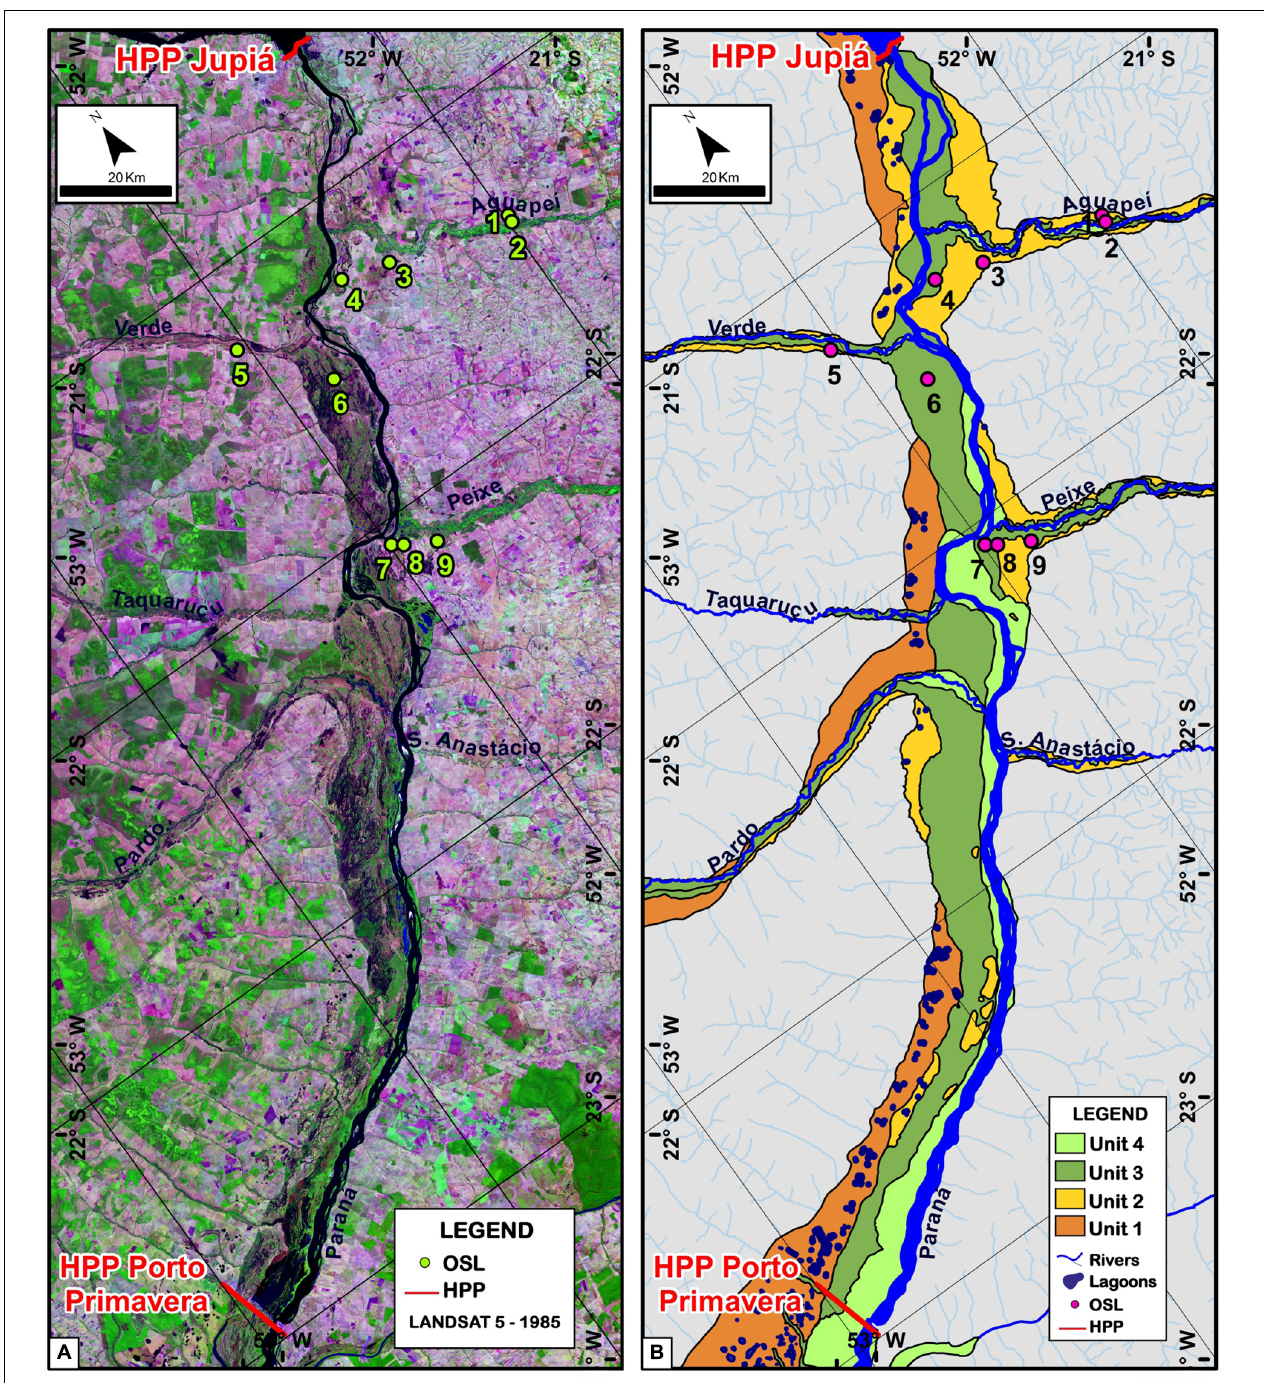
FIGURE 2 | Geomorphology of the Upper Paraná River. (A) Landsat image, composition 5R4G3B, 1985 (before the dam). (B) Geomorphological zones of the fluvial plain and terraces of the study